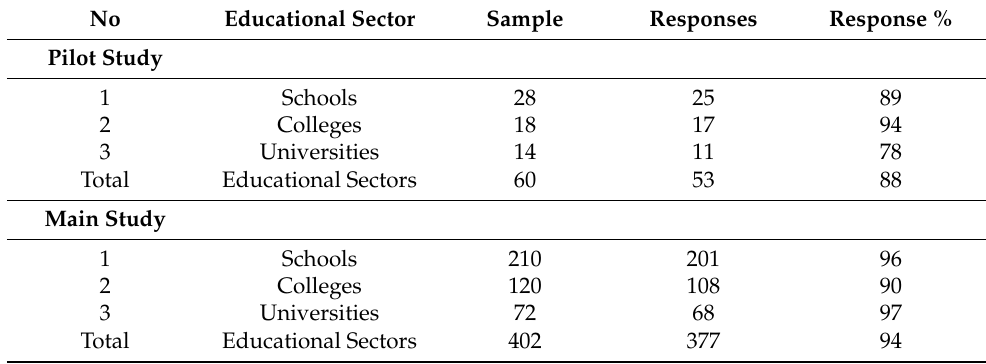
Table 1. Response rate (pilot and main